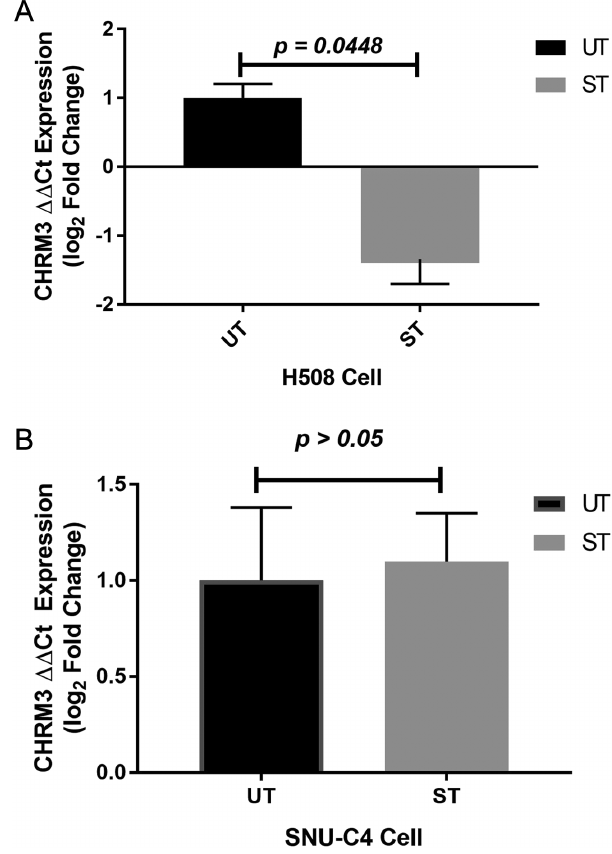
Figure 3. (A) Effects of ST on CHRM3 gene expression of H508 and (B) SNU-C4 human colon cancer cells. The expression levels of CHRM3 mRNA expression in response to the ST treatment compared with untreated (UT). The expression of the CHRM3 level was measured by RT-qPCR. It was normalized by the expression level of SNORD61, SNORD68, SNORD72, SNORD95, and RNU6-2 . Statistical analysis was performed with Student’s t -test. Values represent mean ± SEM (n = 3). RT-qPCR, real-time quantitative polymerase chain reaction SEM, standard error of mean; ST, ST, sodium